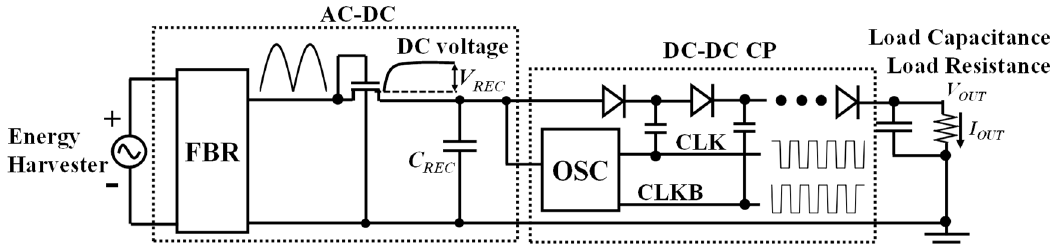
Figure 3. AC-DC-DC CP (FBR: full bridge rectifier, OSC: oscillator).